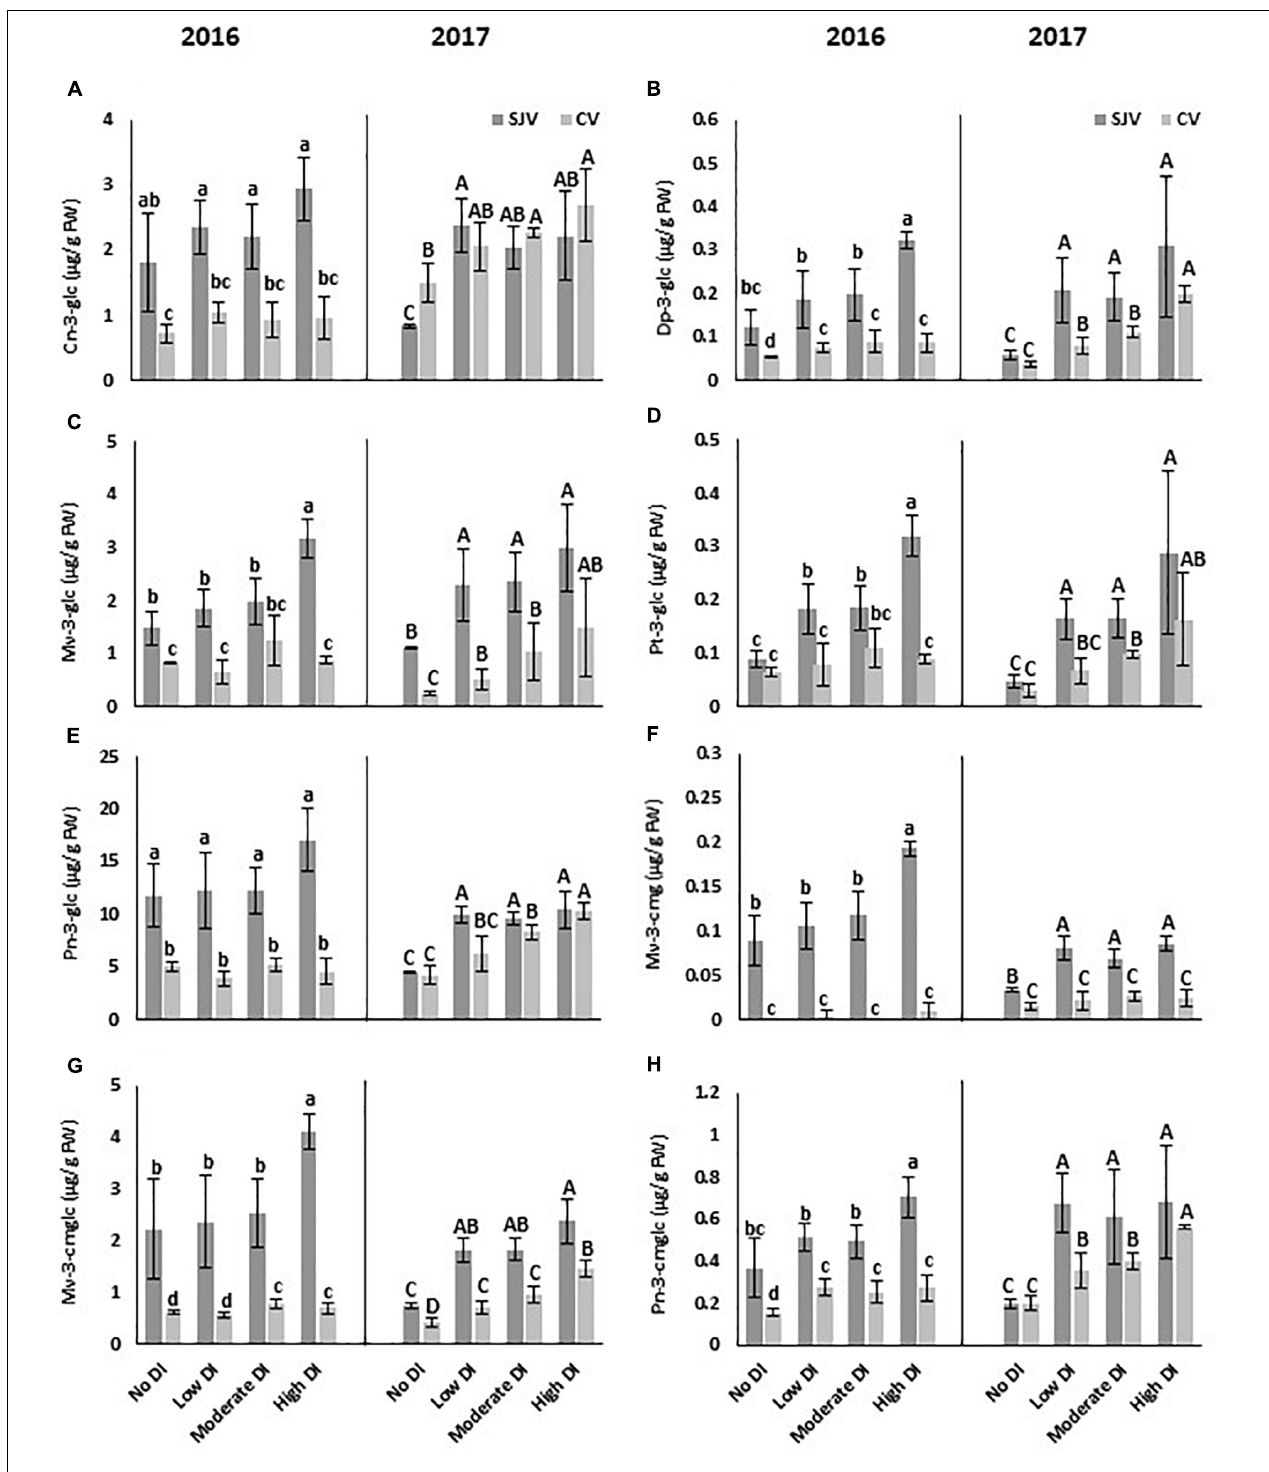
FIGURE 4 | HPLC analysis of different anthocyanin compounds in Scarlet Royal berry skin at harvest in 2016 and 2017, as affected by different deficit irrigation treatments in San Joaquin (SJV) and Coachella (CV) Valleys. The compounds are: cyanidin-3-O-glucoside (Cn-3-glc) (A) , delphinidin-3-glucoside (Dp-3-glc) (B) , malvidin-3-O-glucoside (Mv-3-glc) (C) , petunidin-3-O-glucoside (Pt-3-glc) (D) , peonidin-3-O-glucoside (Pn-3-glc) (E) , malvidin-3-(6-O-coumaroyl)glucoside (cis) (Mv-3-cmg) (F) , malvidin-3-(6-O-coumaroyl)glucoside (trans) (Mv-3-cmglc) (G) , and peonidin-3-(6-O-coumaroyl)glucoside (Pn-3-cmglc) (H) . The error bars represent the standard deviation. Different letters on bars indicate significant differences among treatments and locations at p < 0.05 according to the Tukey HSD test within the same season. Different lower-case letters indicate a significant difference among treatments and locations in 2016 while capital letters are used for 2017.